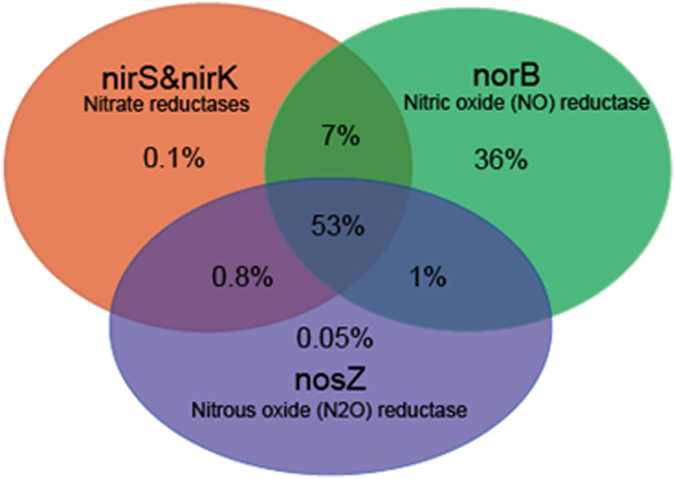
Variation partitioning analysis of target gases emission patterns explained by all denitrification functional genes, three types of ARGs, and microbial diversity by deep metagenomic sequencing; and each circle represents the variation partitioned into the relative effects of each variable or a combination of variables, in which the number indicates to what extend the emission pattern can be explained.Variables explaining more than 0.01% were illustrated in this diagram.